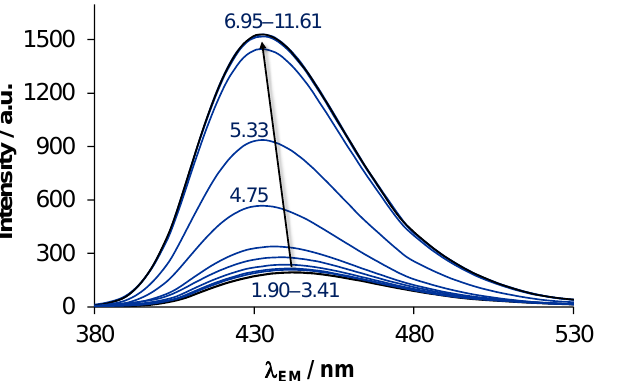
Figure 4. Fluorescence emission spectra of FAVI recorded at various pH values [ c FAVI = 5.0 μM; λ EX = 360 nm; I = 0.1 M (KCl); t = 25 °C]. Figure 3. Distribution coefficient ( D ) of FAVI determined in n -octanol/aqueous systems at various pH values plotted together with the calculated molar fraction of the neutral HL form [ionic strength ( I ) = 0.1 M (KCl); t = 25 °C].